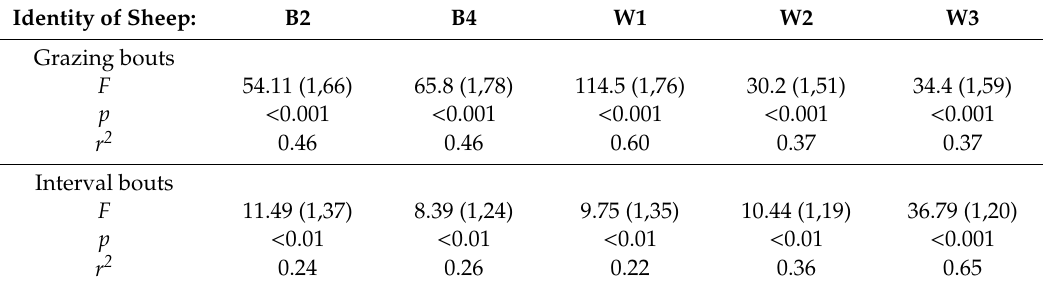
Table 2. Fit of bout lengths to exponential distributions, tabulated by individual sheep, with values of the F statistic (d.f. in brackets), and r 2 (proportion of variance